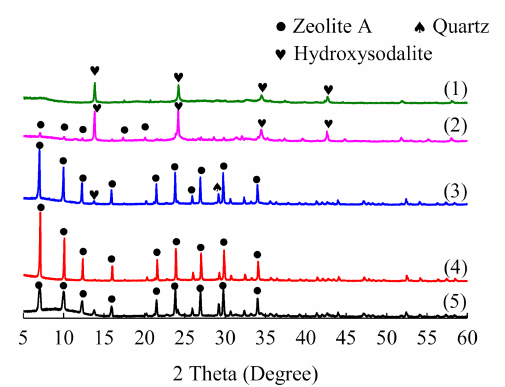
Figure 6. XRD of zeolite A synthesized at di ff erent hydrothermal reaction times. Reaction conditions: m(NaOH) / m(CGFS) = 1.2; solid-phase alkali fusion temperature, 823 K; liquid / solid ratio, 5.5 mL / g; and hydrothermal reaction temperature, 353 K. Hydrothermal reaction time / h: (1) 30 h, (2) 24 h, (3) e unify the format betw18 h, (4) 12 h, and (5) 6